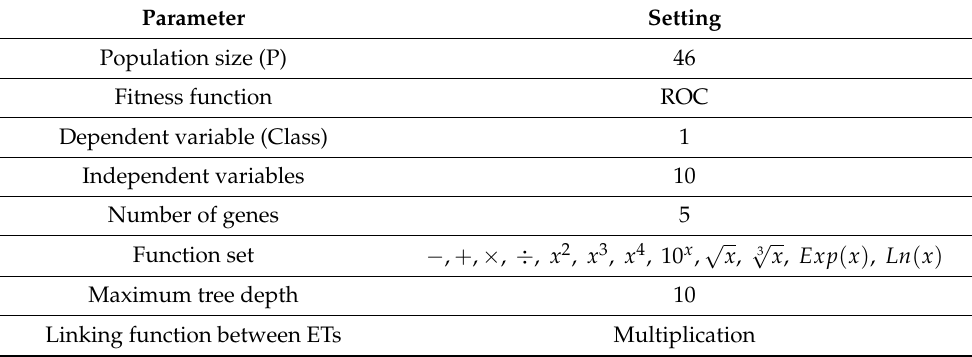
Table 5. List of the GEP